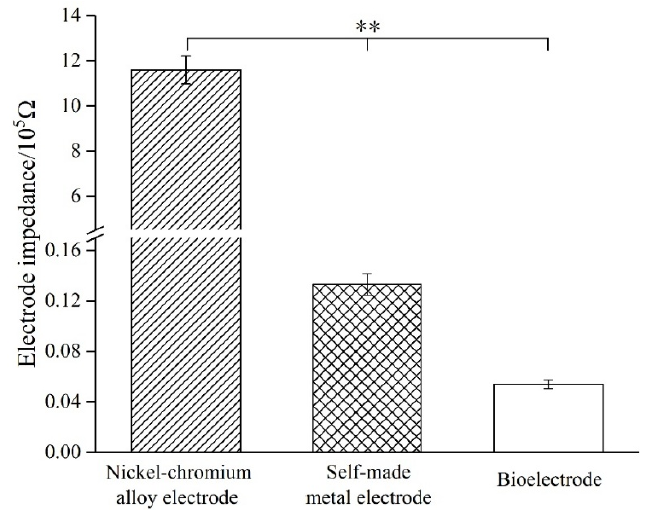
Figure 6. Standard nickel-chromium alloy electrode, self-made metal electrode and self-made bioelectrode impedance at 1 KHz ( n = 4). (** p < 0.01).